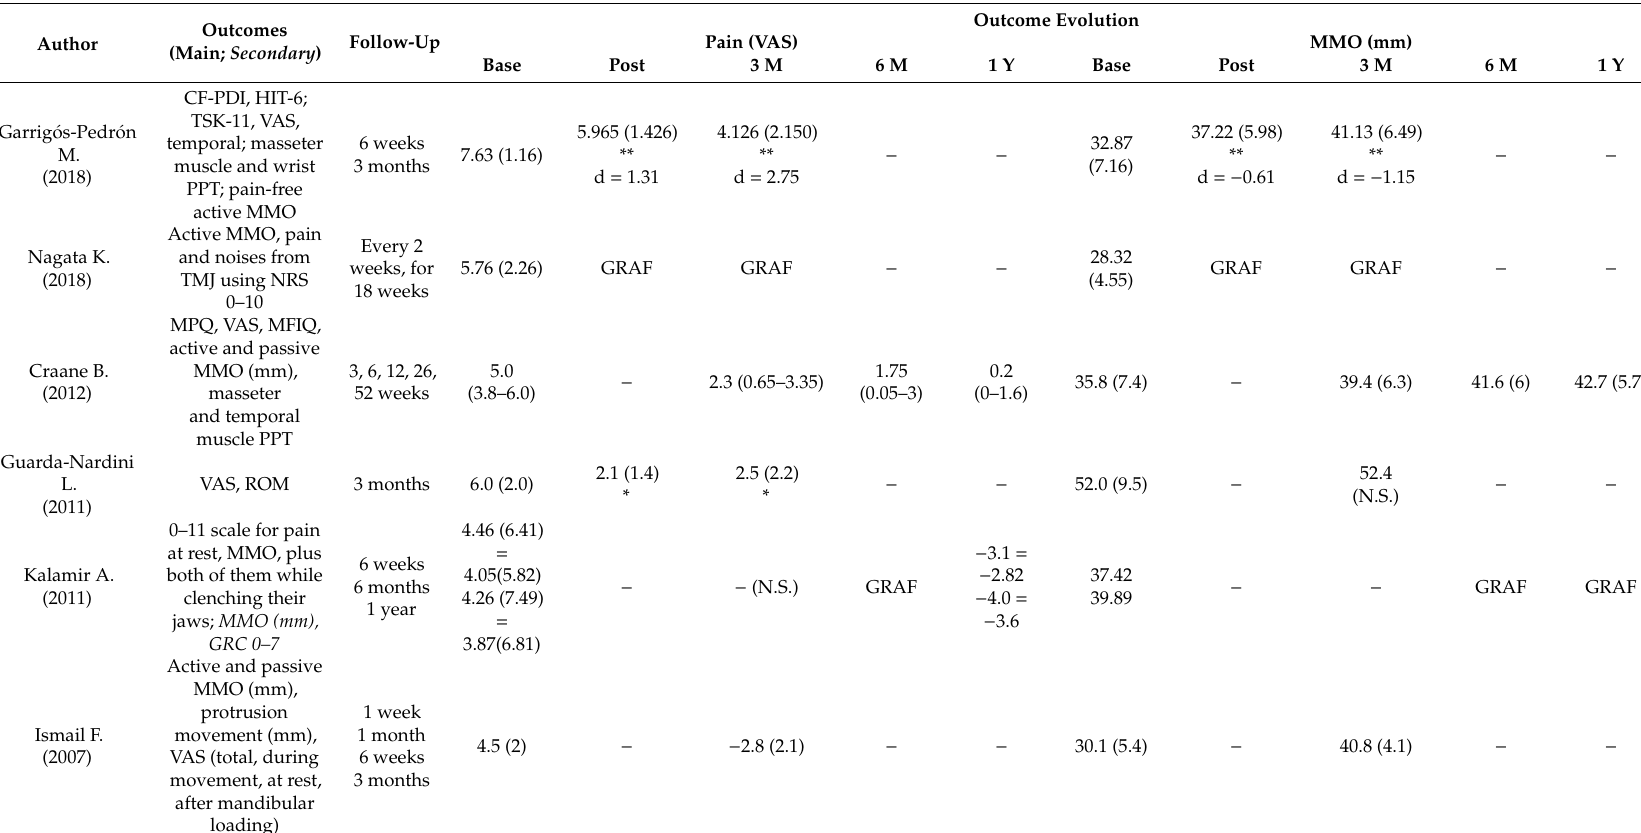
Table 3. Represented results for outcome evolution are those from groups treated with MT. In the case of pain not being measured with VAS, it will be referenced by using a percentage